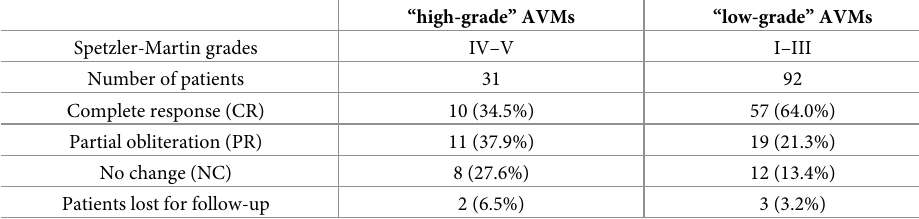
Table 2. Differences in clinical outcomes in “high-grade” vs. “low-grade” AVMs treated with